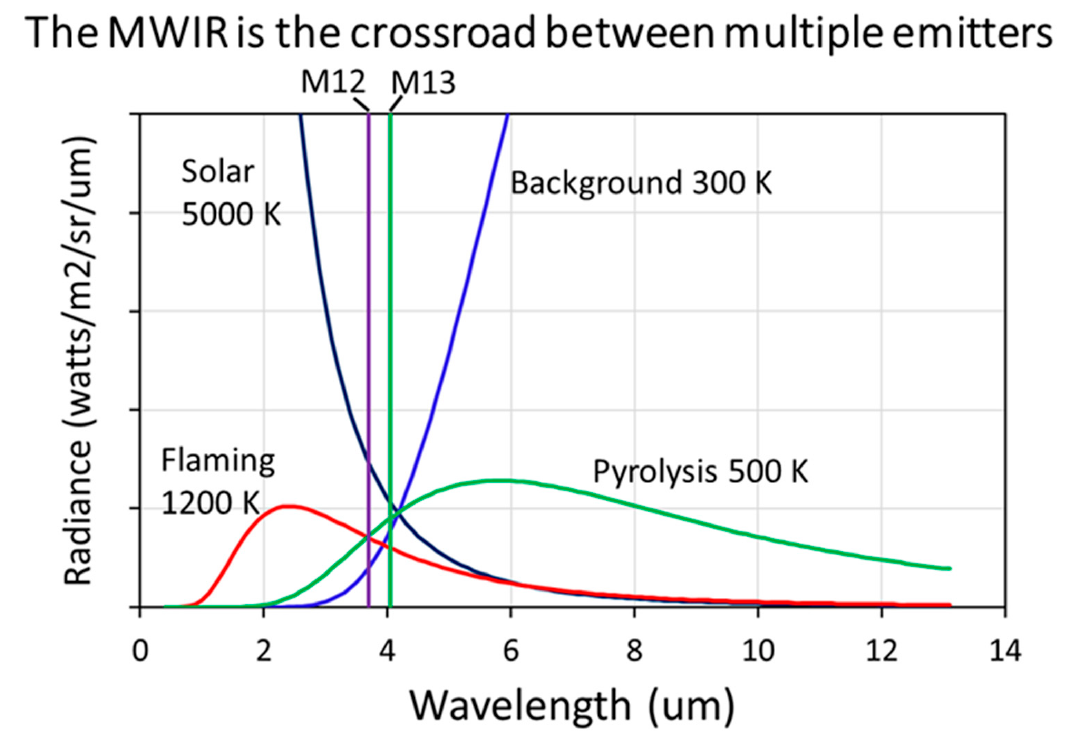
Figure 18. Scaled blackbody Planck curves for objects ranging from 300 to 5000 K. Radiance contributors to the VIIRS MWIR radiances include reflected sunlight, background and temperature phase present in flaming biomass burning and pyrolysis.